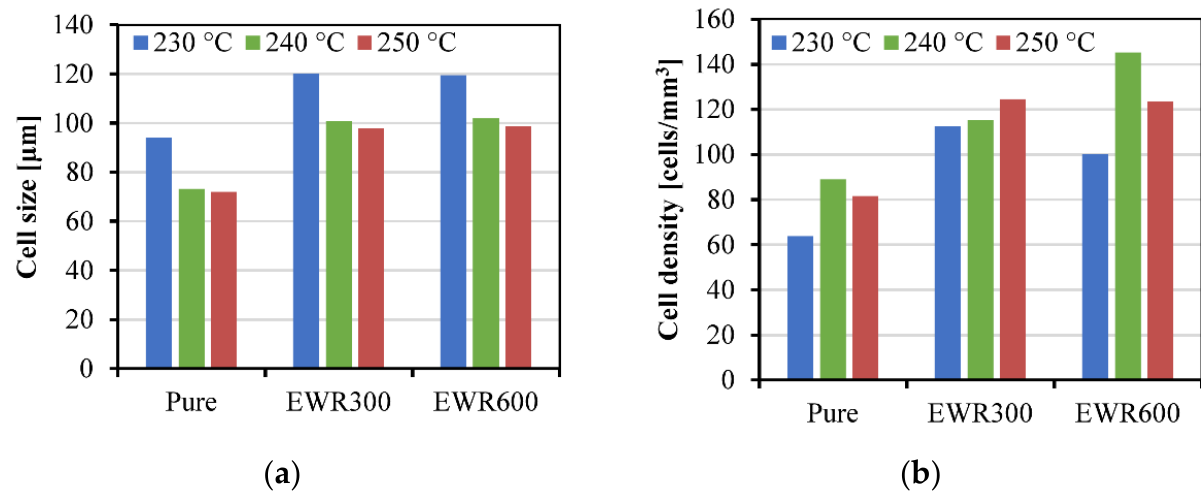
Figure 9. The average cell size ( a ) and cell density ( b ) of the tensile samples with foaming.